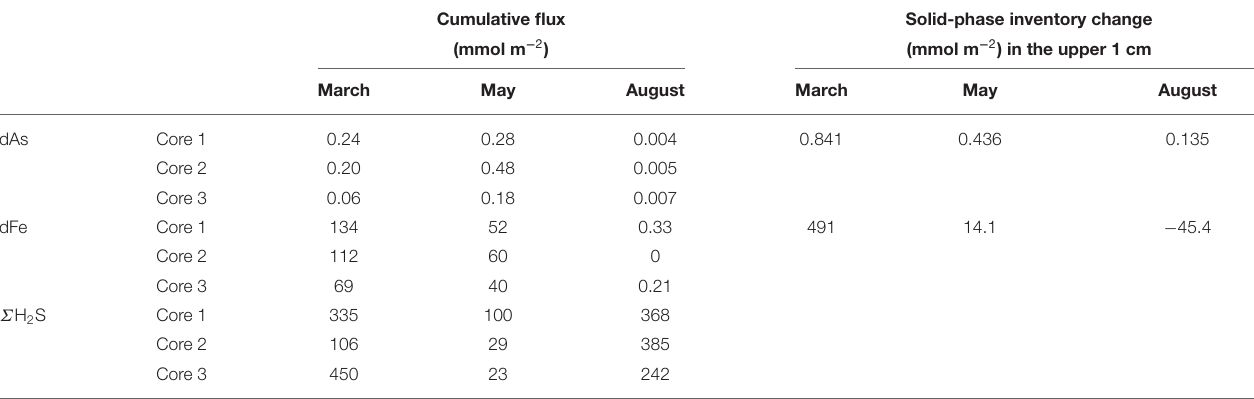
Positive values indicate net loss; negative values indicate net gain. All units are in mmol m − 2 . Solid-phase inventory changes were calculated from ascorbate extractable Fe and As concentrations before and after incubation ( Figure 2